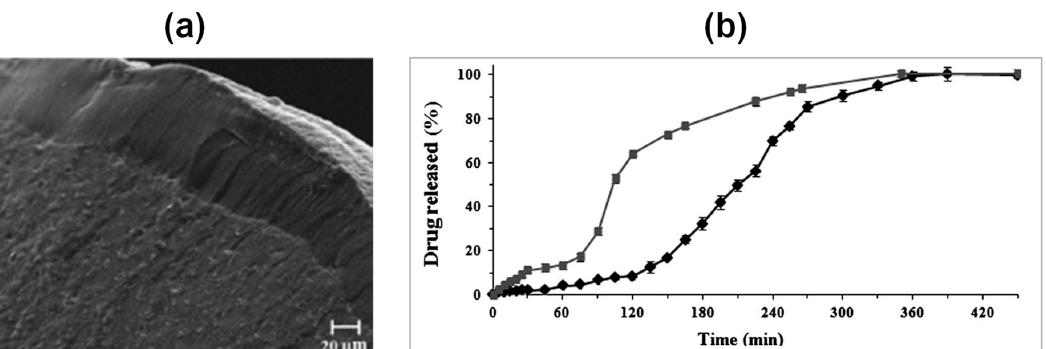
Figure 15. Main in vitro results obtained for core-shell (Pectin / Alginate) beads loaded with piroxicam: ( a ) SEM microphotographs showing the complete and homogeneous alginate shell surrounding the pectin core; ( b ) Release profiles of mono-layered “only core” (Pectin) beads (- (cid:4) -) and bi-layered “core-shell” (Pectin / Alginate) beads (- (cid:7) -), performed in simulated intestinal fluid by using USP Apparatus 2. Reprinted from [43] with permission from Elsevier. Copyright (2014).